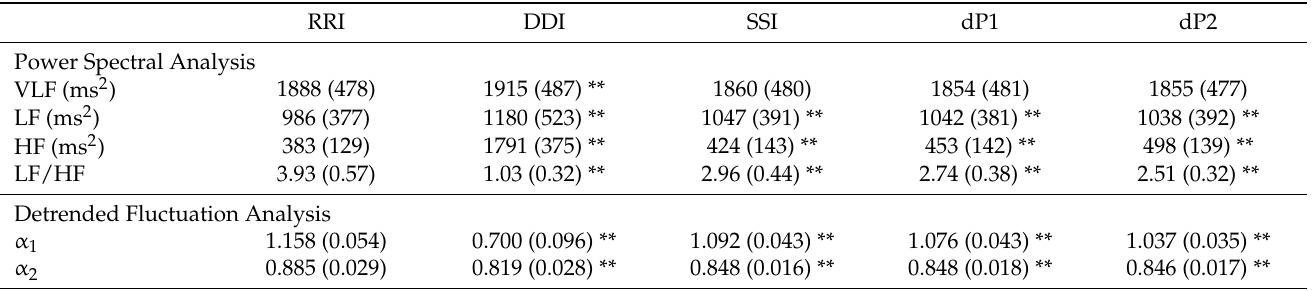
Figure 3. HRV power spectra density (PSD) sleeping at high altitude. Upper panels: geometric mean (solid line) ± geometric standard error (dotted line) for PSD calculated from DDI ( a ), SSI ( b ), dP1 ( c ), and dP2 ( d ) tachograms (black) and the reference RRI (red) over N = 21 participants. Lower panels: spectral ratios between DDI ( e ), SSI ( f ), dP1 ( g ), and dP2 ( h ) tachograms and the reference tachogram: median (solid line) with 1st and 3rd quartiles (dotted line) and V-statistics of Wilcoxon rank test; at frequencies where the V-value is above the 5% (or 1%) significance threshold (dashed horizontal line) the spectral ratio differs from 1 at the 5% (or 1%) statistical significance. Grey/white areas indicate the frequency bands for evaluating VLF, LF, and HF powers. Table 1. HRV indexes in n = 21 participants sleeping at high altitude: median (SE median) by type of